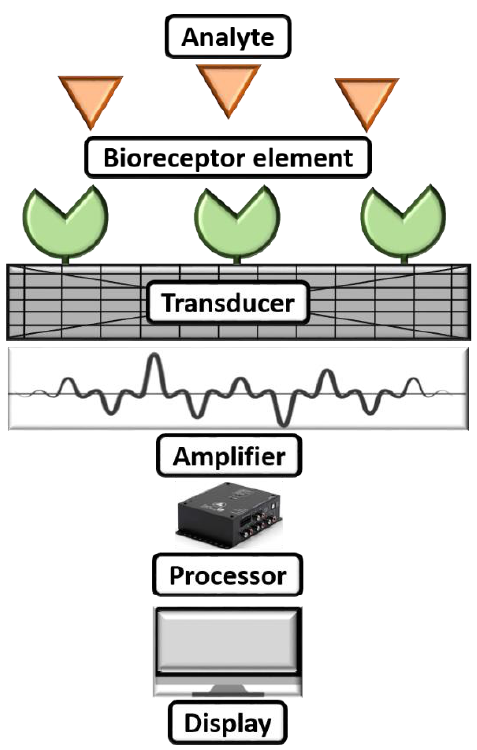
Figure 3. Working mechanism of a biosensor.